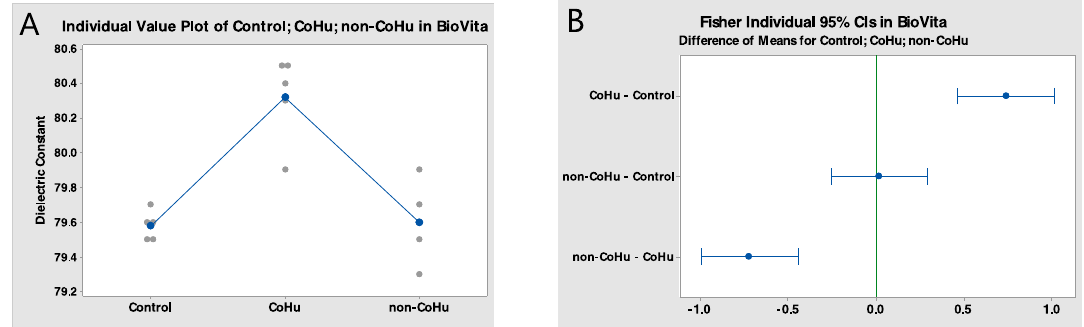
Figure 6. ( A ) BioVita water dielectric constant scattered data in samples treated with CoHu and non-CoHu. ( B ) Fisher pairwise comparisons for dielectric constant measurements in BioVita natural water. CIs are confidence intervals. If an interval does not contain zero, the corresponding means are significantly different.